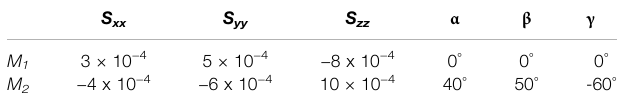
TABLE 1 | Order tensors used for RDC